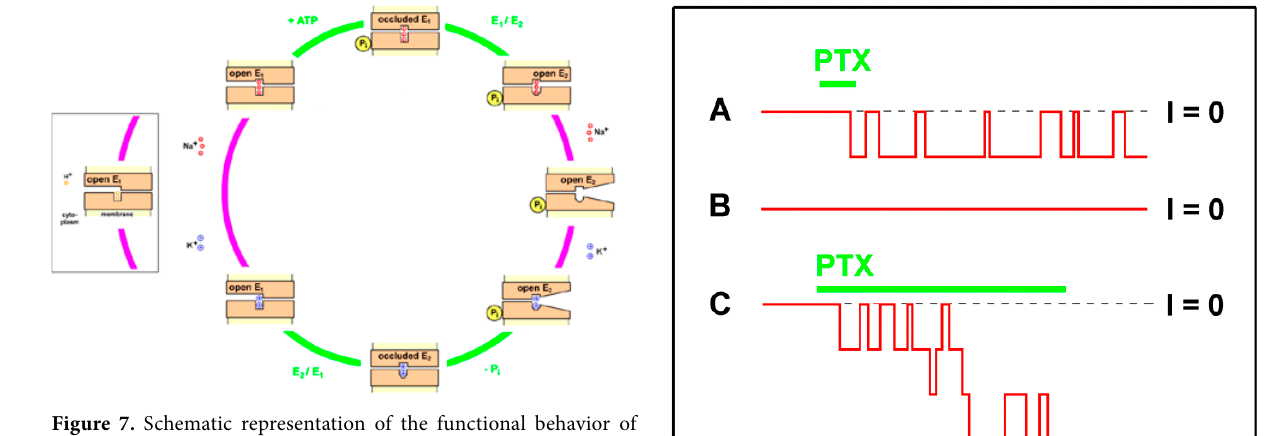
Figure 7. Schematic representation of the functional behavior of the Na,K-ATPase membrane domain (the cytoplasmic domain is omitted for clarity) in characteristic states of the pump cycle. The ion binding sites are located almost in the center of the membrane domain and are accessible from the cytoplasm in the E 1 conforma- tion and from the extracellular aqueous phase in P-E 2 . The open states in both conformations are separated by occluded states in which no ions may move within the access channels. In the P-E 2 conformation the initially narrow access channel widens up after release of the first Na + . The pink fractions of the cycle indicate elec- trogenic (ion uptake and release), the green ones represent electro- neutral processes (phosphorylation/dephosphorylation, conforma- tion transition). While in the P-E 2 conformation the ion-binding sites may be empty, in the E 1 conformation the binding sites are occupied by protons in the absence of other monovalent cations (due to the high affinity for protons in E 1 ) as insinuated by the inset.